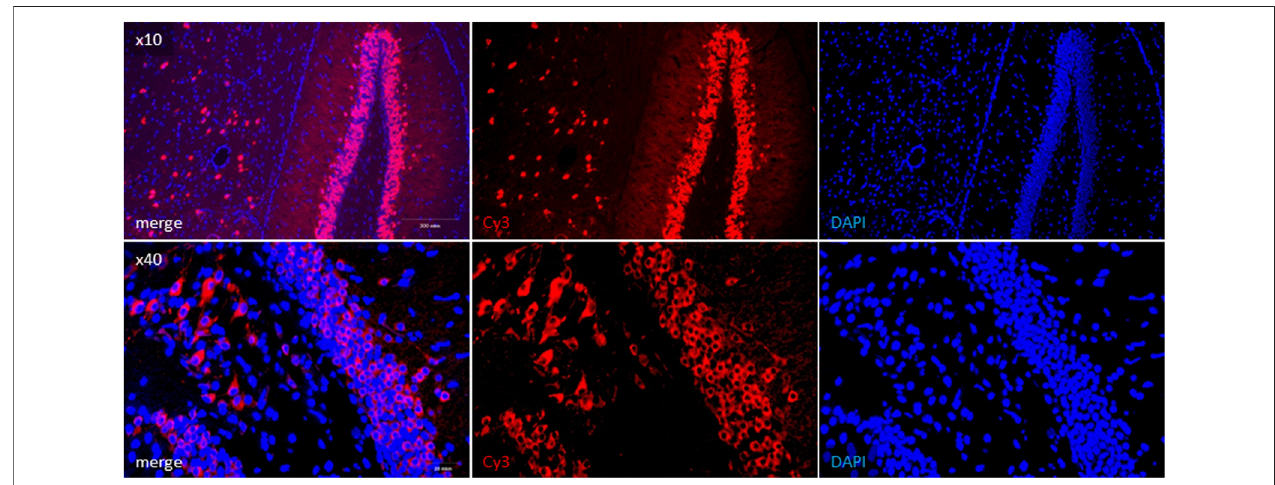
FIGURE4| ImmunohistochemicaldetectionofSARS-CoV-2N-proteininUBC- ACE2 Tx brainsamples.ViralN-proteinwaslabeledwithCy3-conjugatedsecondary antibody (red fi eld). Cell nuclei and DNA were stained with DAPI (blue fi